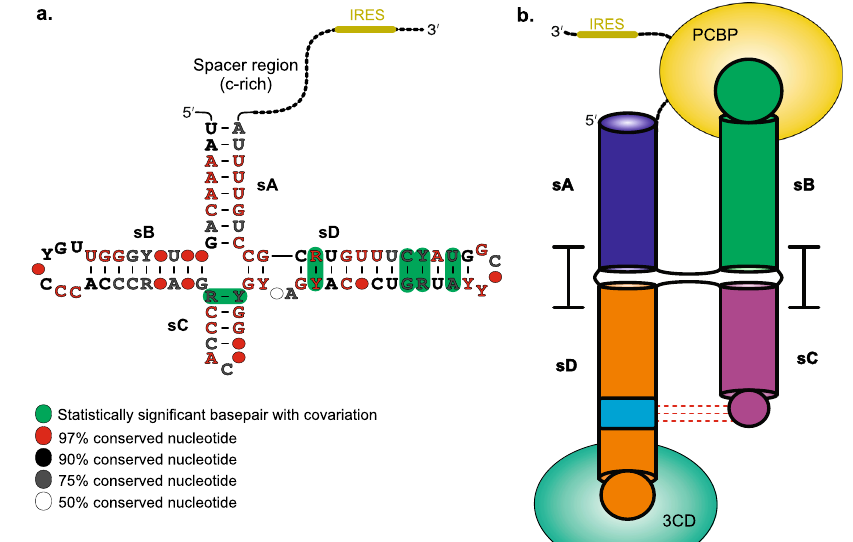
Fig. 5 | Consensus structural model of the enteroviral 5 ′ CLs. a Proposed sec- ondary structural model of consensus enteroviral 5 ′ CL (also see Supplementary Fig. 20 for details).The 5 ′ CLs are one of the most conserved RNA elements among enteroviruses ( b ) The three-dimensional consensus fold of the 5 ′ CLs in enteroviral